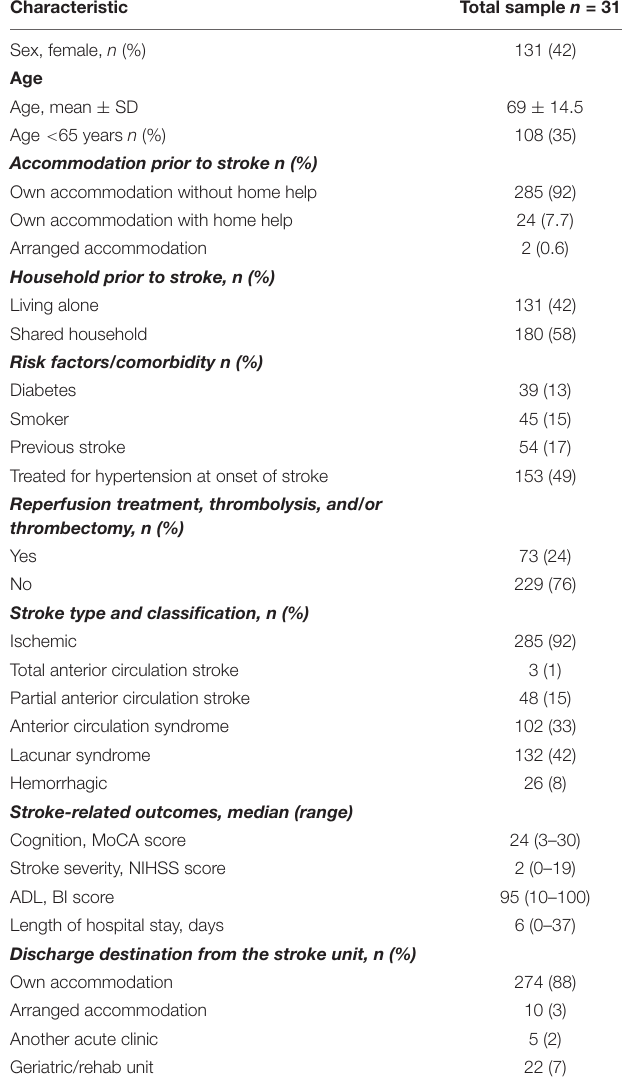
TABLE 1 | Baseline characteristics of the study participants ( n =